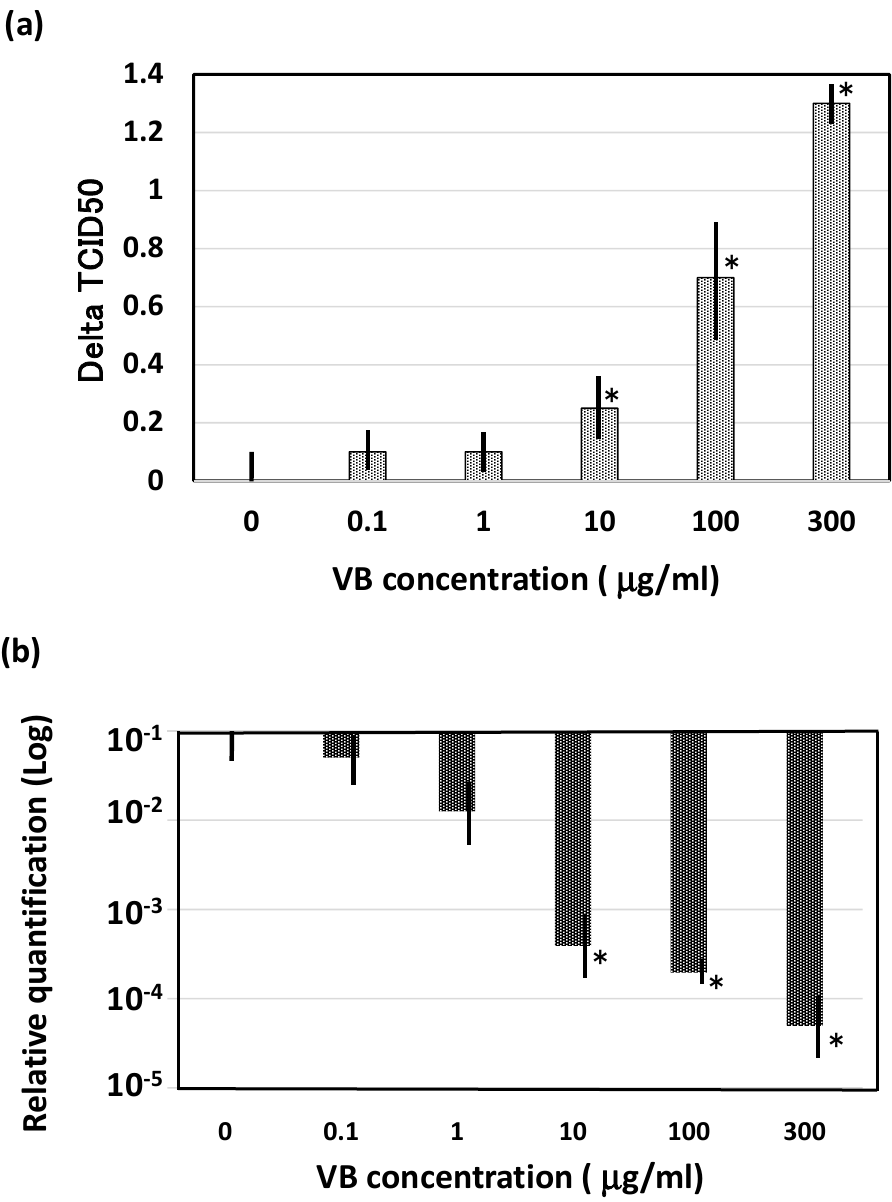
Figure 2. Direct inactivating e ff ects of VB on viruses. ( a ) TCID 50 assay; ( b ) relative quantitative RT–PCR. * p < 0.001 relative to the virus control (VB, 0 µ g /